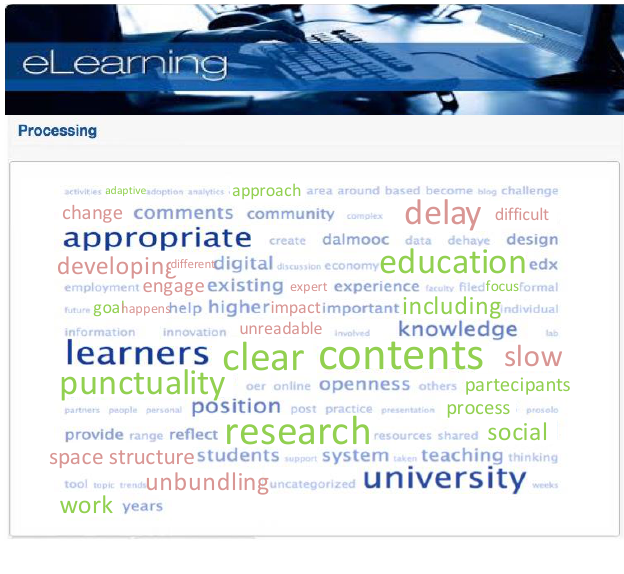
Figure 3 : The tag cloud